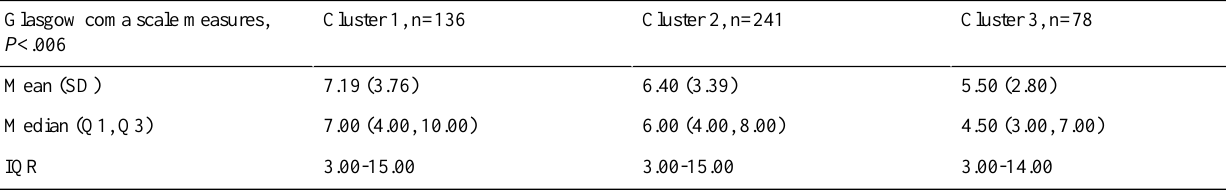
Table 4. Total Glasgow Coma Scale measures by cluster (N=455).